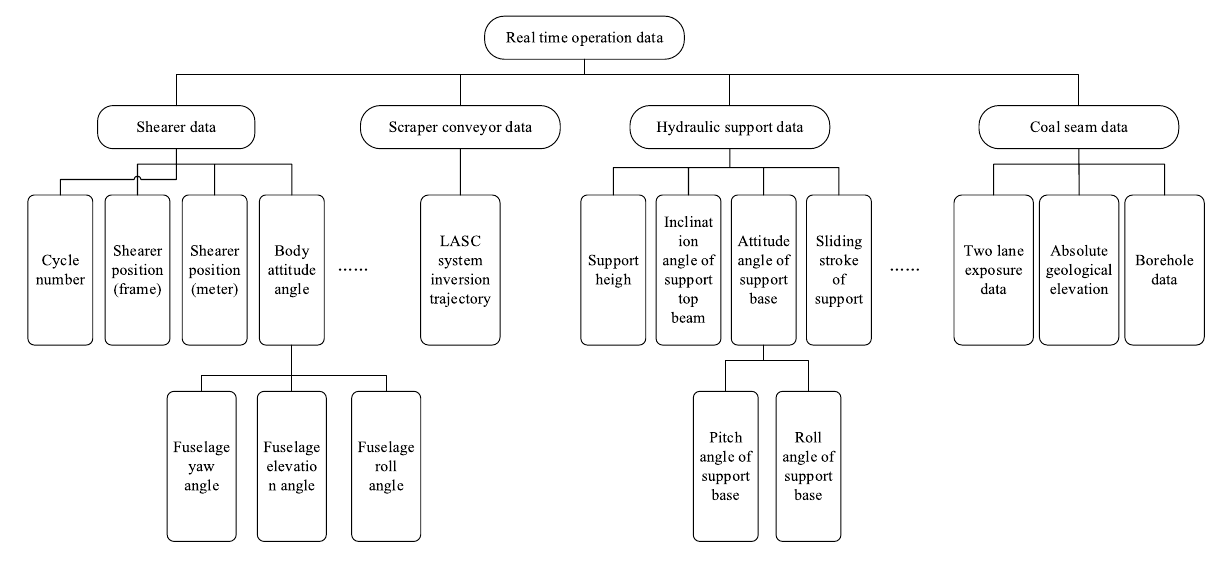
Fig. 4 Relevant equipment and coal seam data for 100